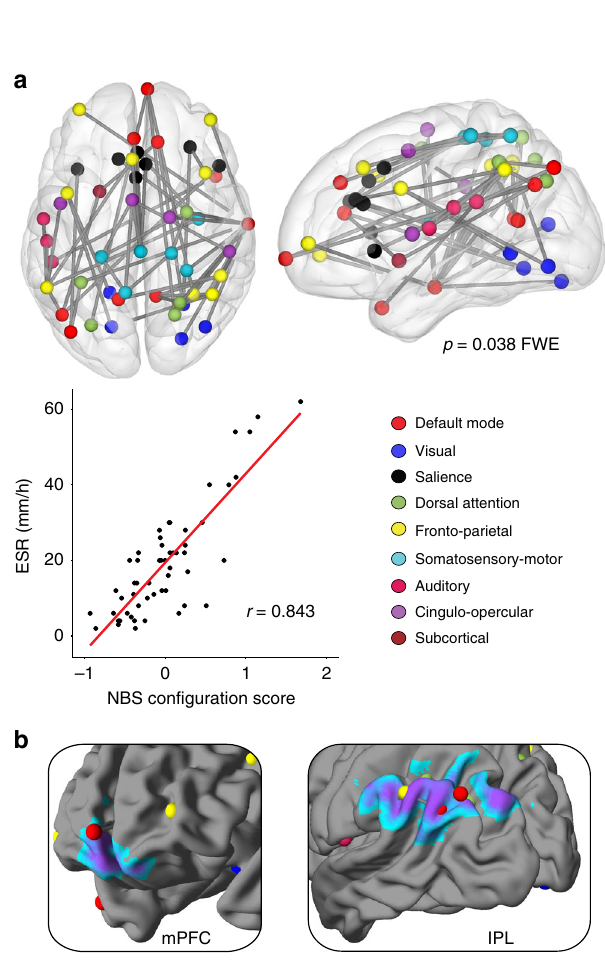
Fig. 5 Summary of in fl ammation-associated functional connectivity changes. a Nodes and edges showing the Network-Based Statistic (NBS) in fl ammation con fi guration, with scatterplot showing the association (Pearson correlation) between erythrocyte sedimentation rate (ESR) and the average strength of connectivity across the 54 edges. Undirected and weighted Fisher z -transformed bivariate correlation matrices of connectivity were created for each subject from 10 mm diameter spheres at the 264 nodes of the Power atlas (264 × 264 matrices). Identi fi ed nodes and edges associated in aggregate with higher ESR are derived from permutation testing at family wise error corrected p < 0.05. b Overlap of regions of positive connectivity identi fi ed through seed network to whole-brain analyses and nodes identi fi ed through NBS analyses of higher in fl